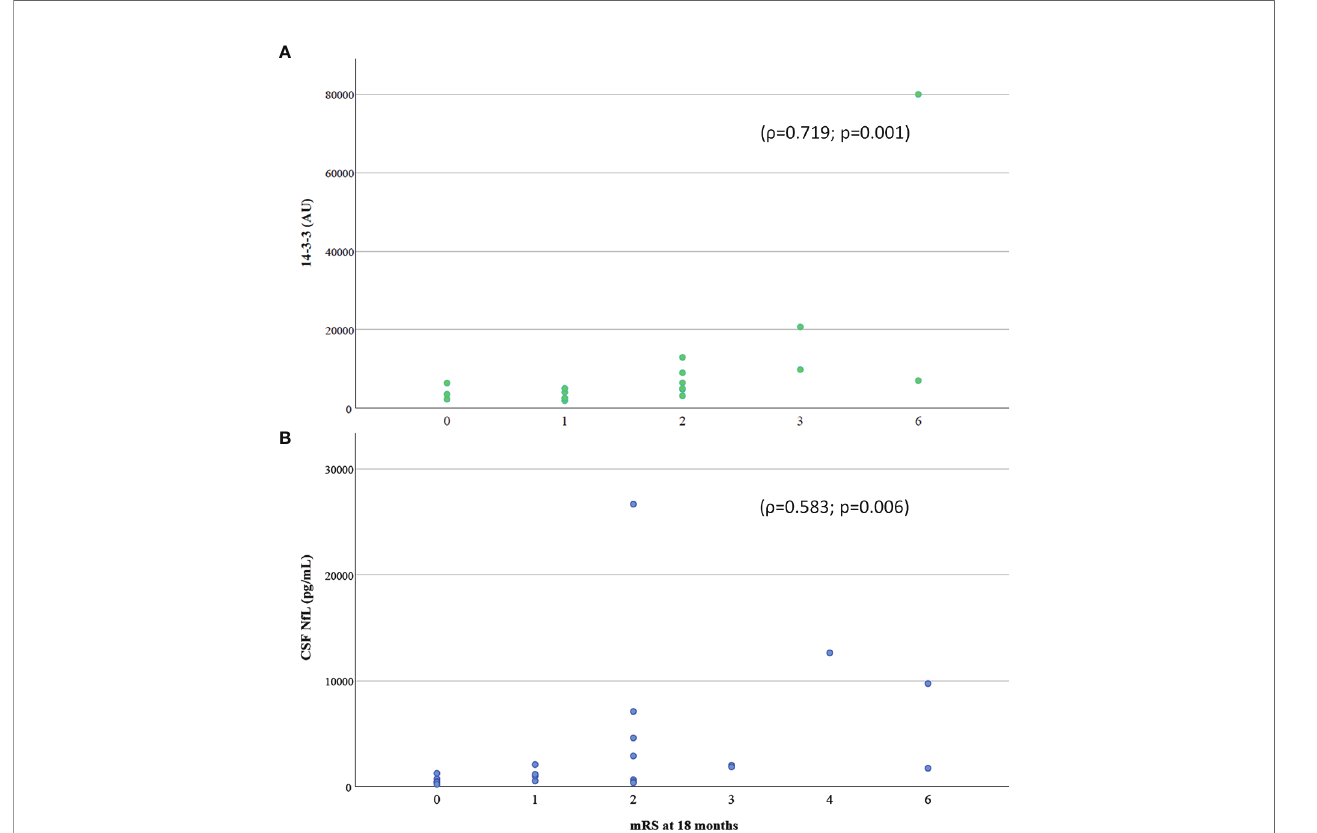
FIGURE 3 | Correlation of (A) 14-3-3 protein and (B) NfL in CSF with functional outcome assessed with mRS at 18 months follow-up. CSF, cerebrospinal fl uid; mRS, modi fi ed Rankin